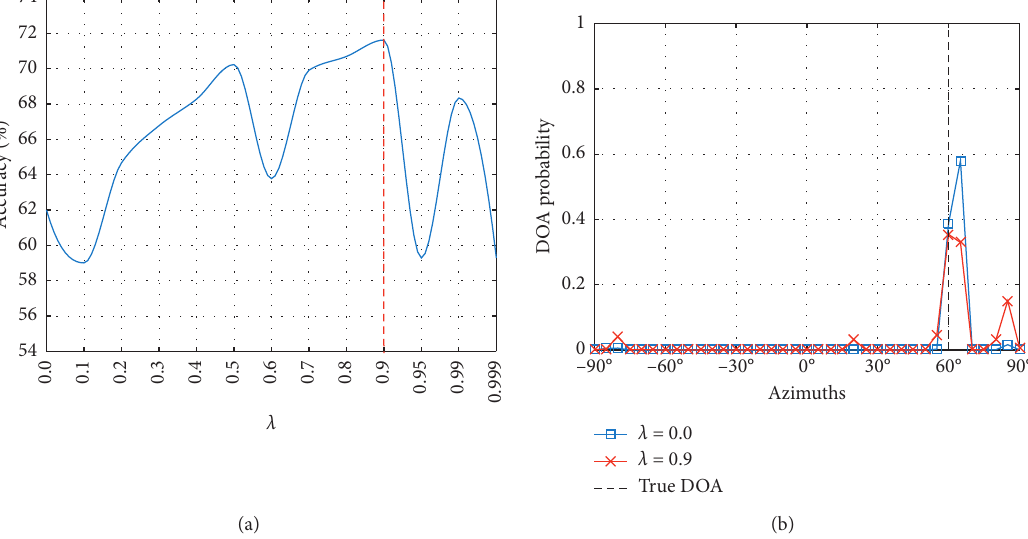
Figure 2: (a) Evaluation of the learning factor λ . (b) DOA probabilities for a noise-dominant frame positioned at 60 °